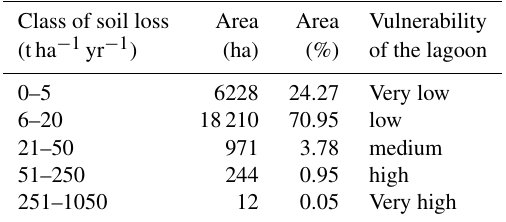
Table 4. Vulnerability of Aghien lagoon to soil loss in 2017. Class of soil loss